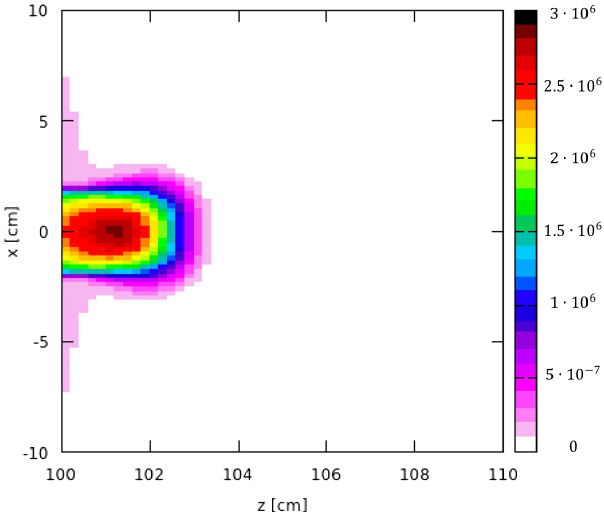
FIG. 13. Two-dimensional projection of the dose map in the water phantom for the 7 MeV electron beam. Dose values are plotted using a linear color scale. Units are GeV/g per primary electron.